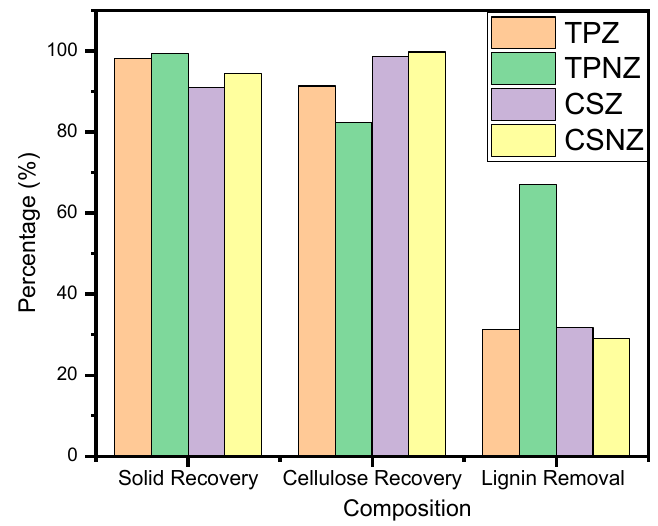
Figure 2. Solid recovery, cellulose recovery, and lignin removal of the two substrates under the different pretreatments.